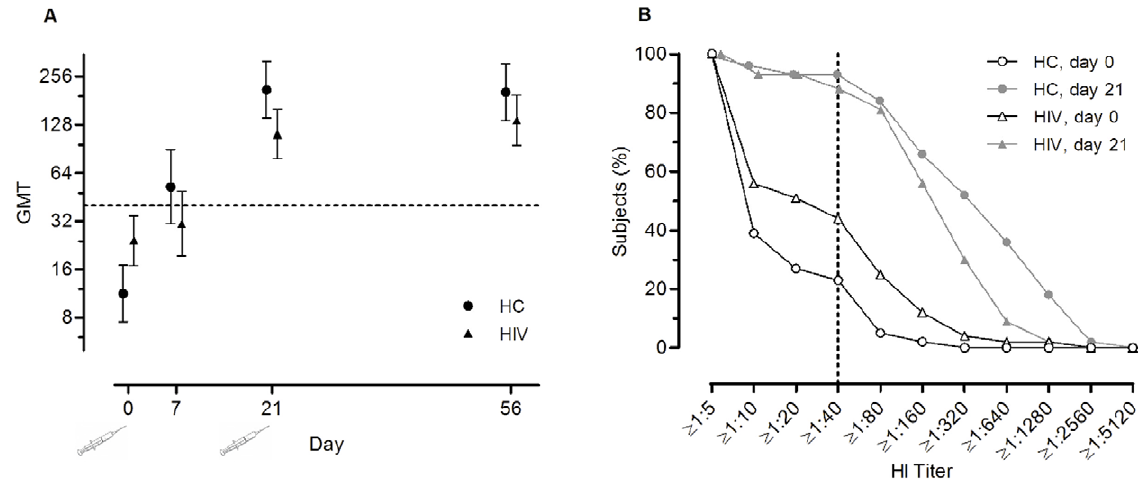
Figure 1. Immunogenicity of two doses of pH1N1 vaccine. Monovalent MF59-adjuvanted pandemic influenza vaccine (A/California/7/2009) administered to a group of 57 HIV-infected patients (HIV) and 44 healthy controls (HC). The vaccine was administered at day 0 (baseline) and at day 21. Age adjusted geometric mean titers with 95% confidence intervals at baseline, day 7, day 21 and day 56 (Panel A). Reverse cumulative distribution curves on hemagglutination inhibition assay at baseline and at day 21 (Panel